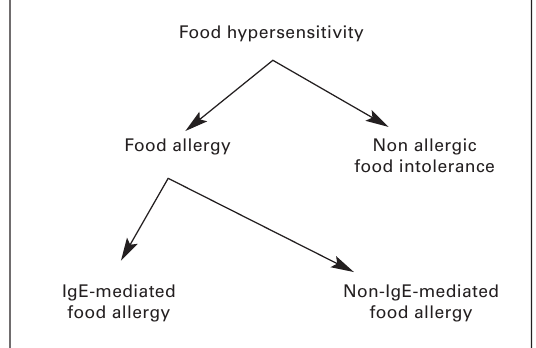
Classification of food hypersensitivity. Adapted from Johansson SG